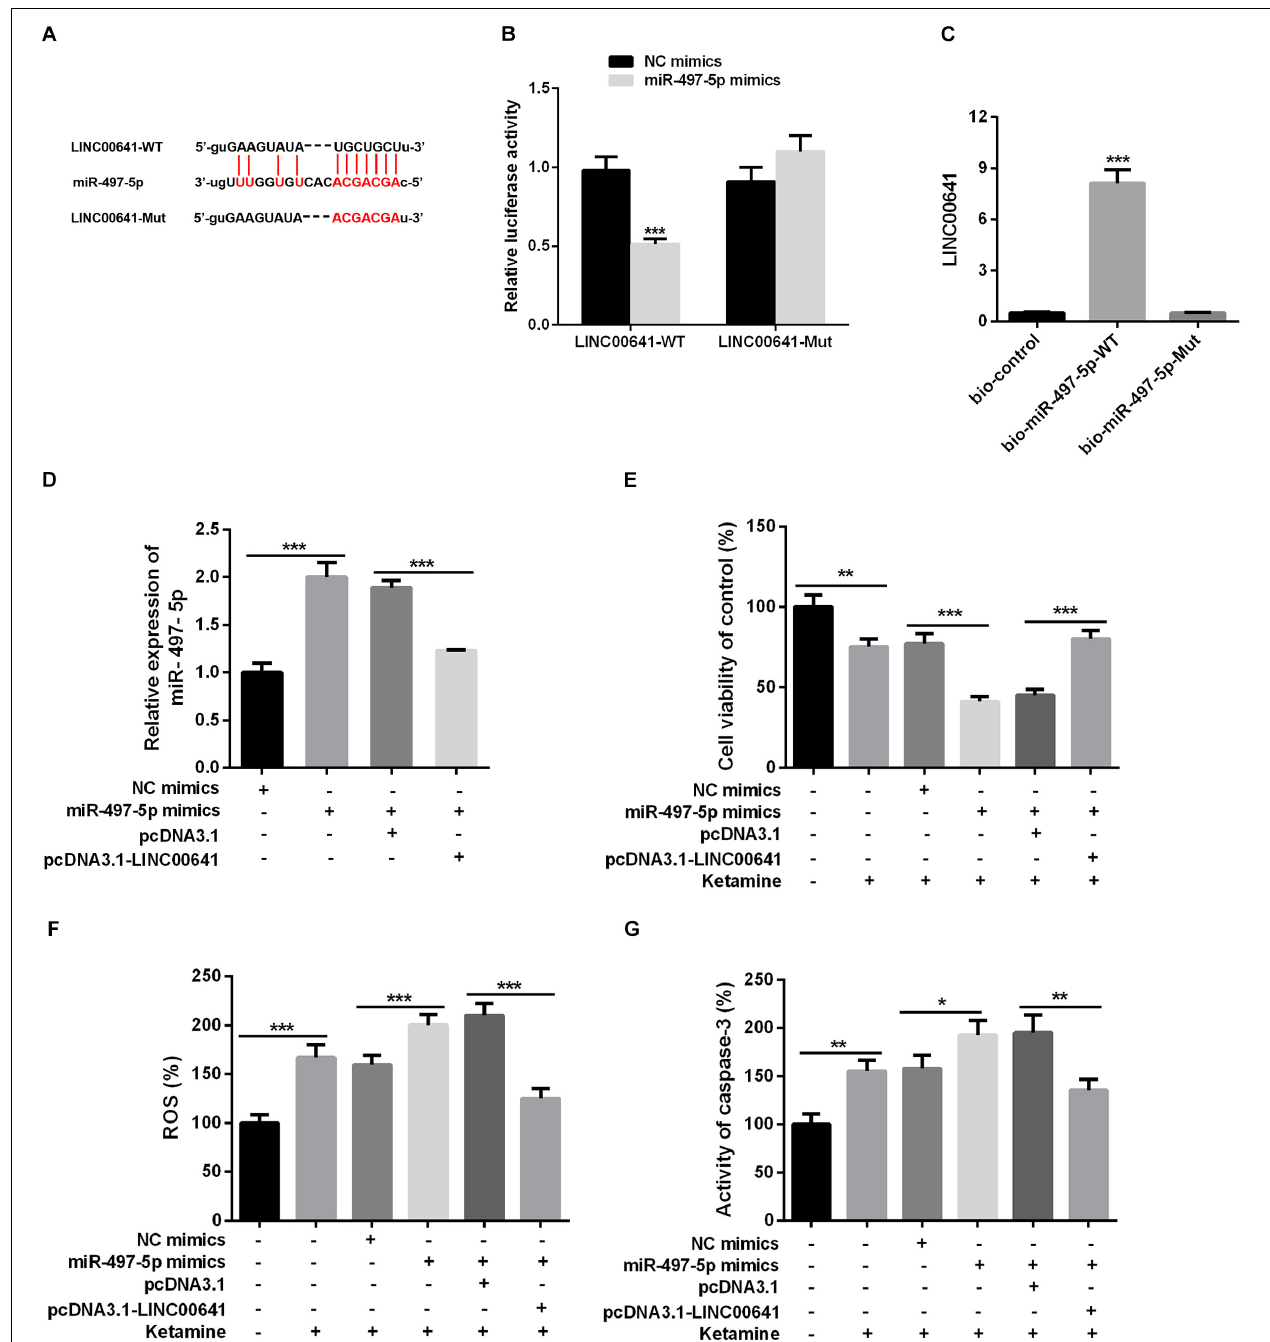
FIGURE 3 | LINC00641 targeted miR-497-5p. (A) The binding sites between LINC00641 and miR-497-5p. (B) Dual-luciferase reporter assay was conducted to verify the relationship between miR-497-5p and LINC00641, *** P < 0.001 vs. NC mimic group. (C) RNA pull-down assay showed that miR-497-5p could directly bind LINC00641, ** P < 0.01 vs. bio-control group. (D) qPCR was employed to detect the relative expression after overexpression of LINC00641 in miR-497-5p mimics cell line. (E) MTT assay was adopted to detect neuronal cell viability in different cell lines. (F) Neuronal cell ROS levels in different cell lines was detected by ROS detection kit. (G) Caspase-3 activity was detected by caspase3 detection kit. * P < 0.05, ** P < 0.01, and *** P < 0.001.